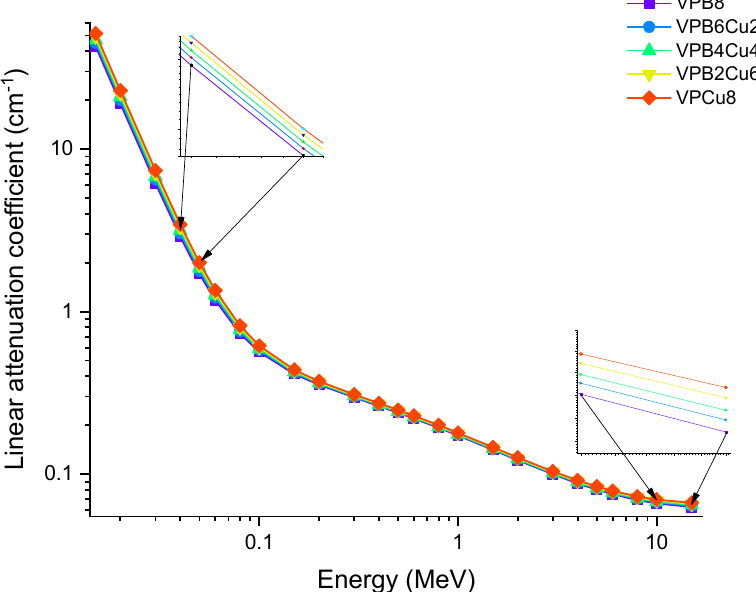
Figure 4. Variation of linear attenuation coefficient ( μ ) against photon energy for VPB x Cu y glass samples.